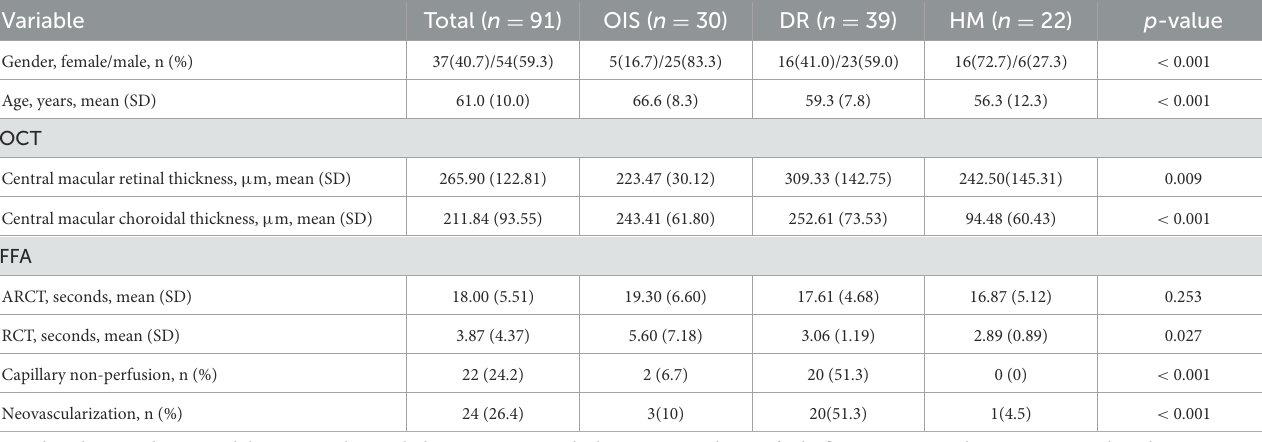
TABLE 1 Demographics and ocular characteristics.